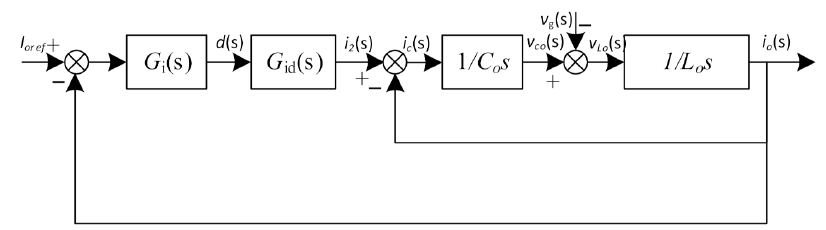
Figure 9. Model of current closed loop with LC filter.